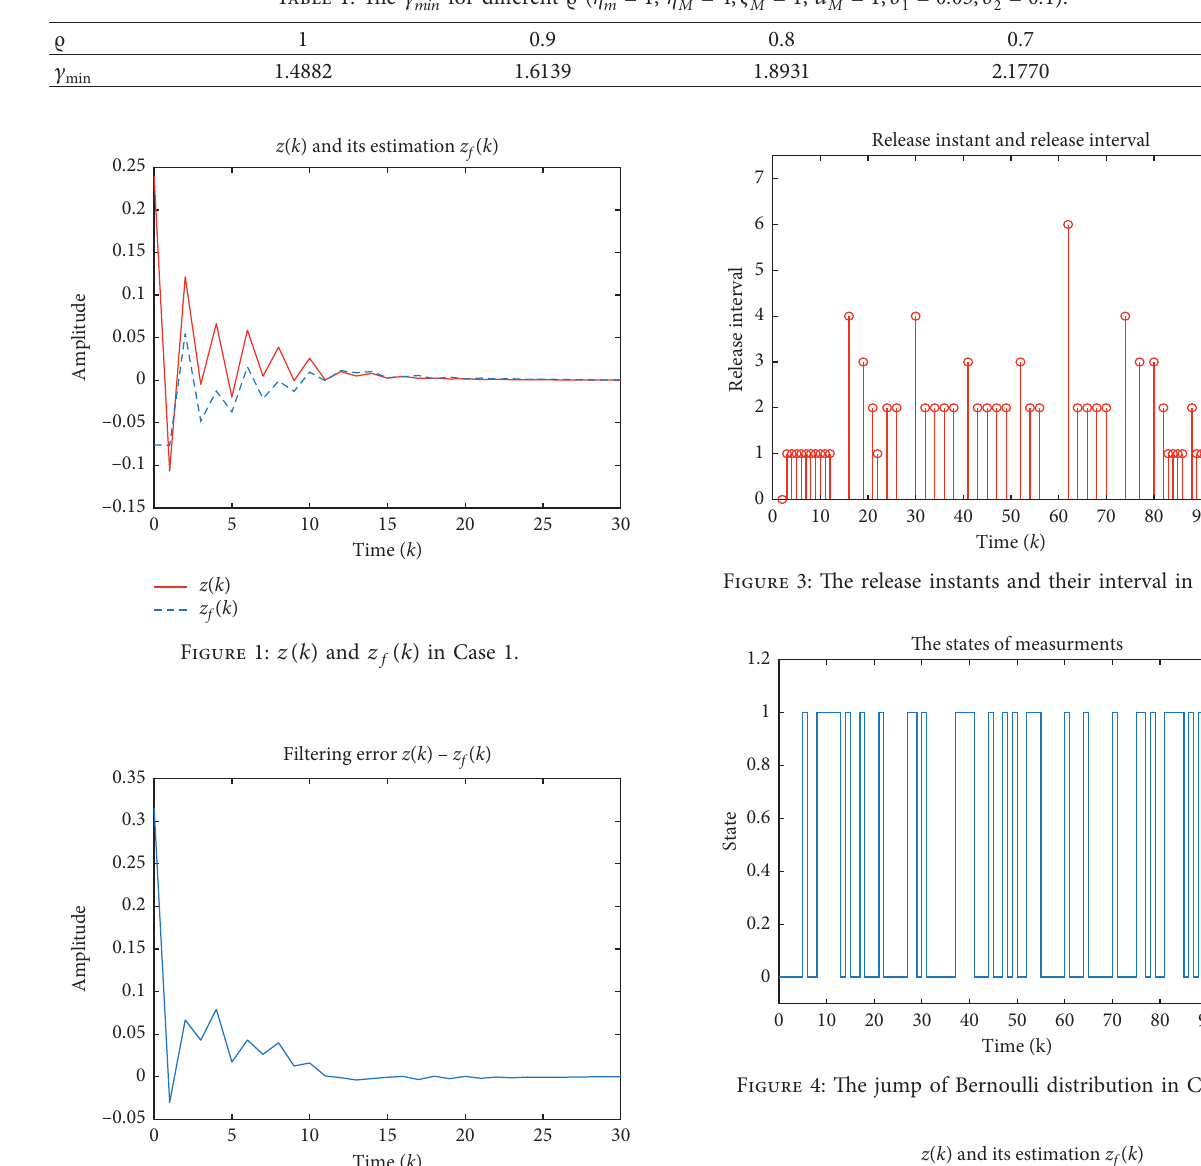
min for different ϱ ( η m